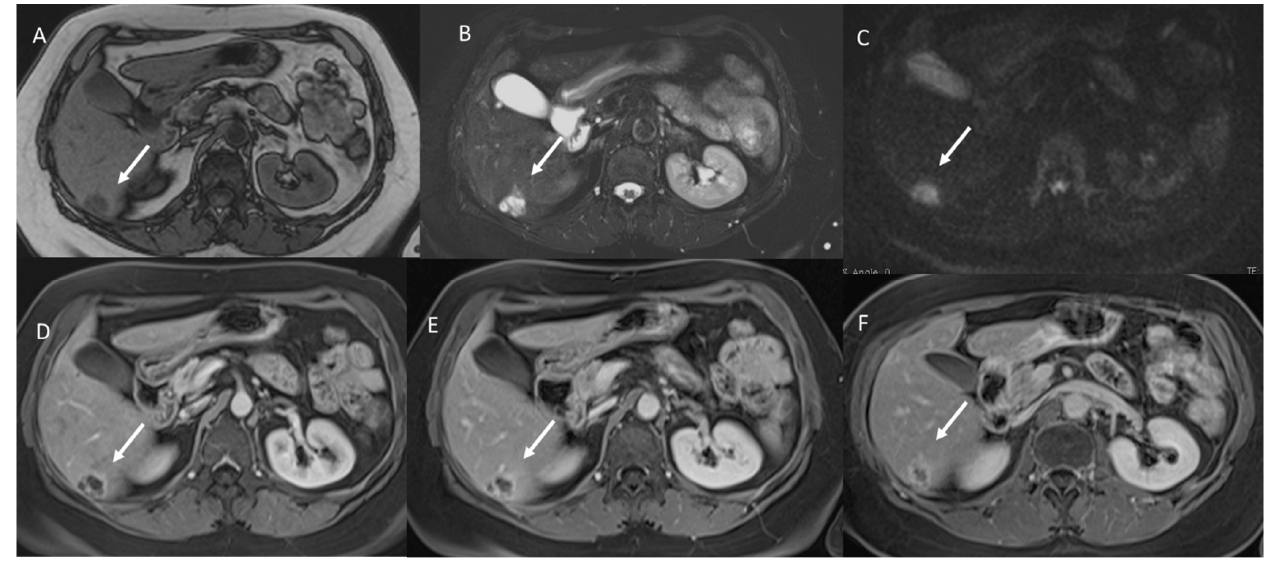
Figure 2. Mucinous liver metastasis (arrow) on VI hepatic segment. In ( A ) T1-W image, the lesion shows hypointense signal. In ( B ), the lesion shows very high SI in T2-W and restricted diffusion in b800 s/mm 2 ( C ). During contrast study (( D ) arterial phase, ( E ) portal phase and ( F ) equilibrium phase), the lesion shows Rim APHE in all phases.